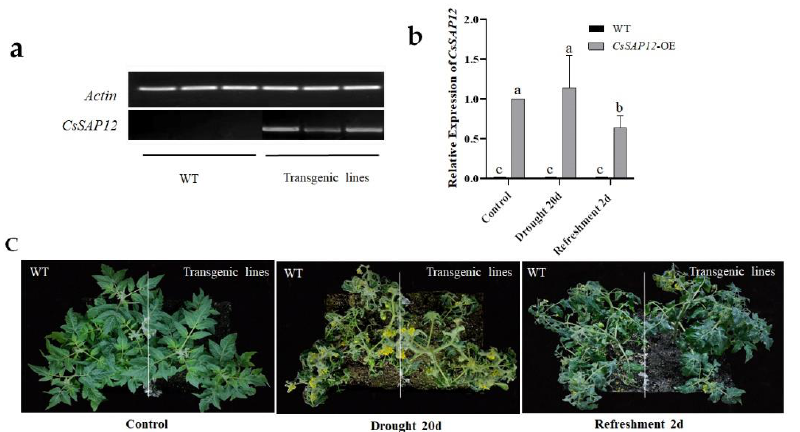
Figure 6. Identification of transgenic tomato lines under drought stress. ( a ) Semi-quantitative PCR analysis of the CsSAP12 expression level. ( b ) Relative expression of CsSAP12 in leaves of WT and transgenic plants. ( c ) Phenotypes of WT and transgenic lines under drought stress. The values are expressed as the mean ± standard deviation, and different letters of the alphabet represent significant differences calculated by Duncan’s multiple range test ( p < 0.05).